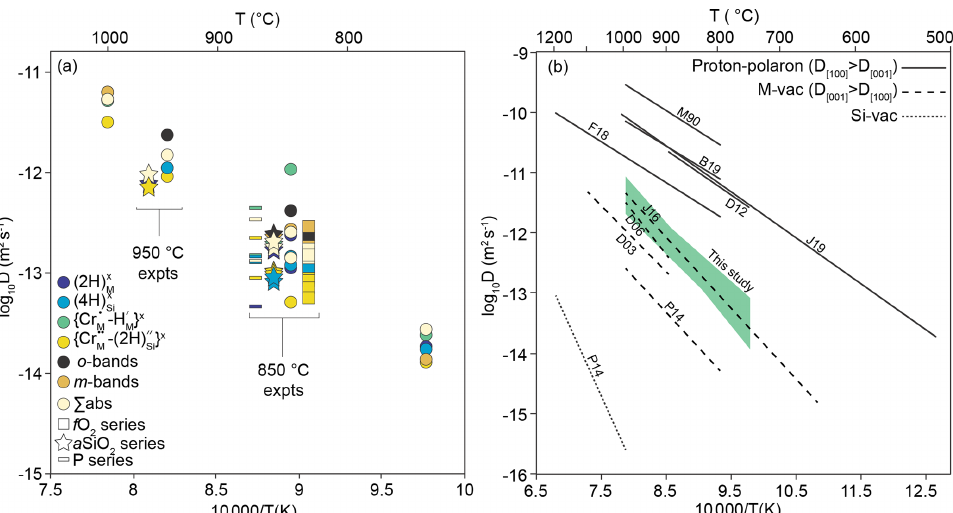
Figure 12. (a) Diffusion coefficients as a function of inverse temperature, for five resolved defects, and total H. Also shown are data from experiments conducted at different f O 2 (squares), a SiO 2 (stars) and pressure (rectangles). Points from 850 and 950 ◦ C experiments are offset for clarity. See the Supplement for uncertainties. (b) ˜ D from this study along with ˜ D from other studies. The shaded area represents the range of Arrhenius parameters in Table 4. Data are grouped into three associations: (1) where ˜ D [ 100 ] > ˜ D [ 001 ] (proton–polaron